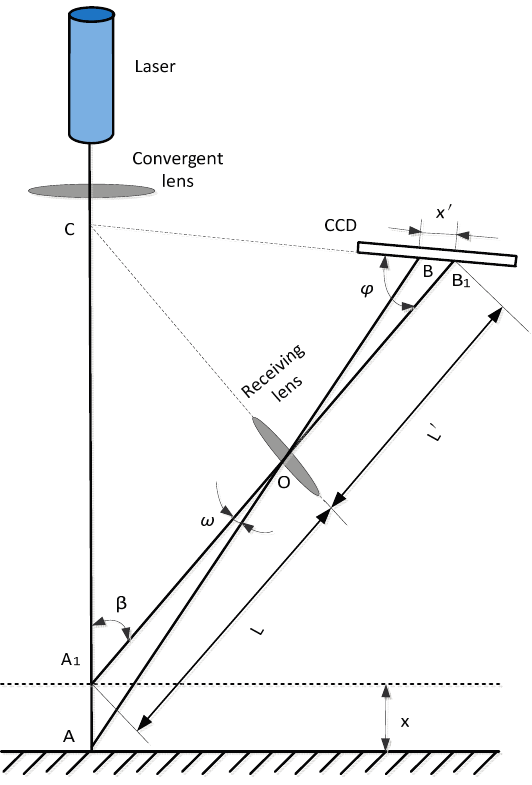
Figure 5. The schematic diagram of direct laser